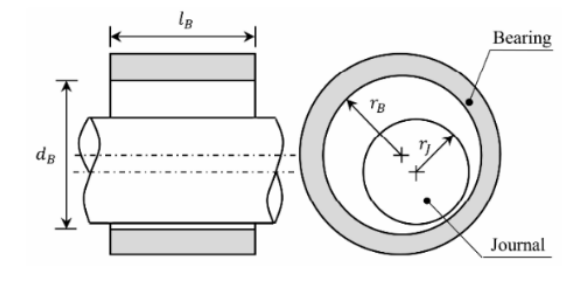
Fig. 3: Revolute joint with